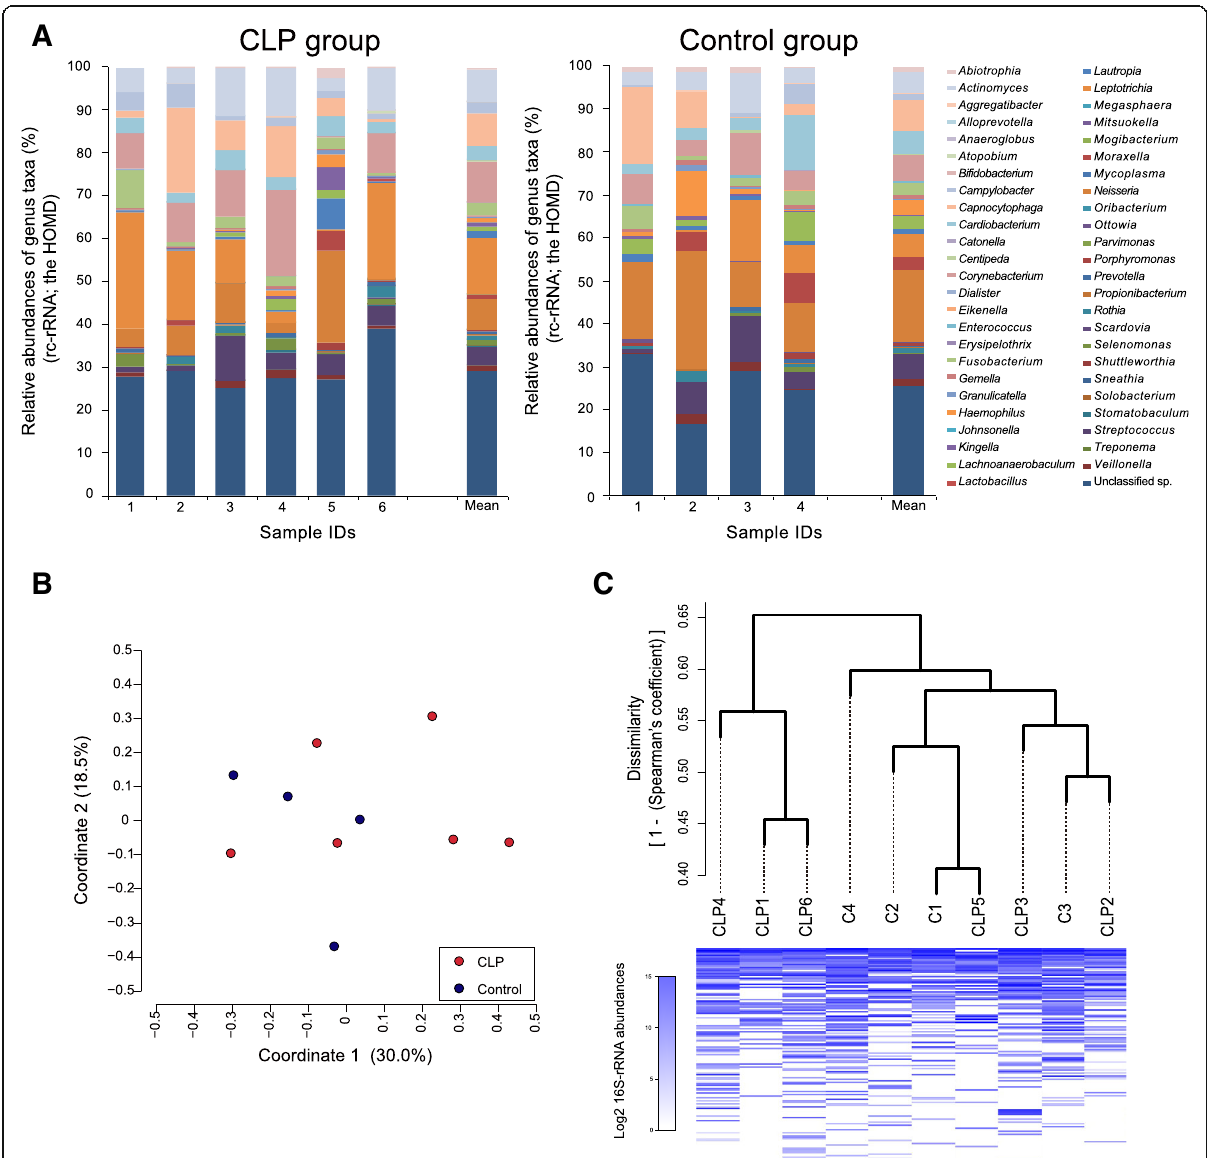
Fig. 1 Bacterial composition estimated from 16S rRNA reads. a The bar charts present the bacterial composition assigned with the HOMD at the genus level, shown as the relative abundance. Each color corresponds to the genus indicated on the right side. b First coordinates in the PCoA for the bacterial composition assigned with the HOMD are plotted with second coordinates in the scatter graph. The CLP and control participants are indicated by red and blue, respectively. c The dissimilarity matrix is derived from Spearman ’ s rank correlation coefficient between any two participants and is used to construct a dendrogram of hierarchical clustering. A heat map of log2 rc-rRNA abundances is shown below the